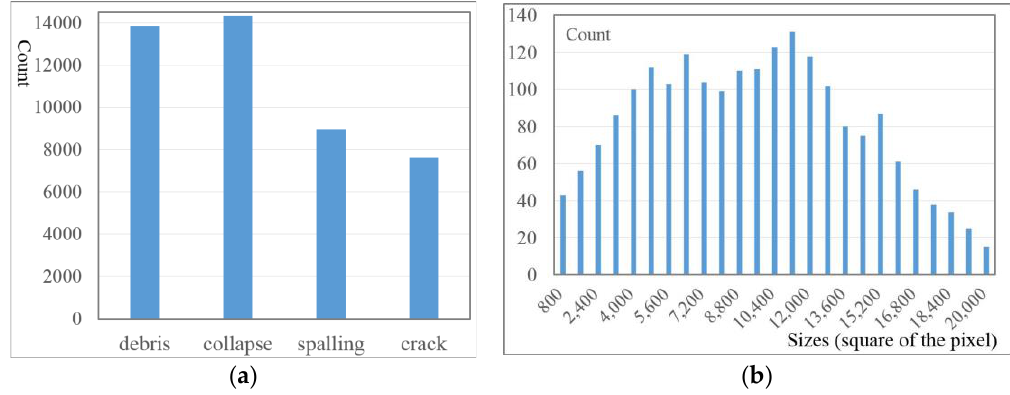
Figure 4. Statistics of different damage types ( a ) and sizes ( b ).